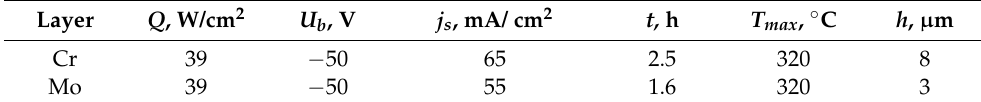
Table 1. Deposition parameters of Cr and Mo